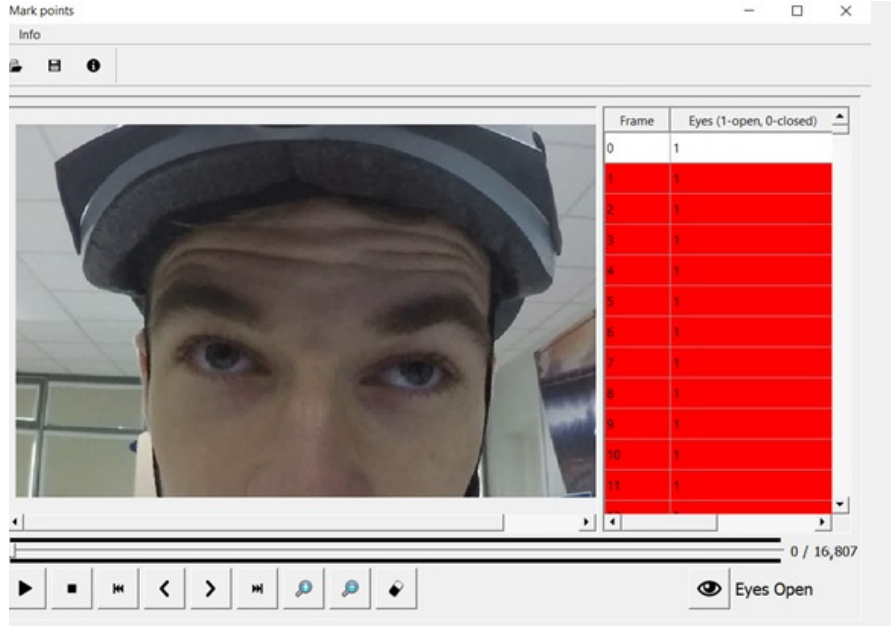
Figure 3. Eye-blink analysis in MarkBlinks programme.